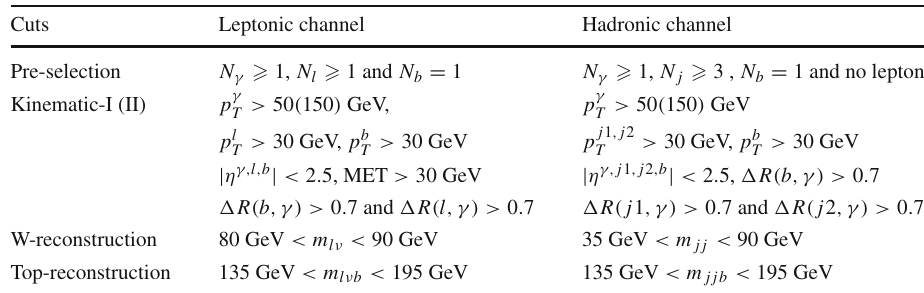
Table 3 The number of signal and relevant background events after each kinematic cuts in the analysis single lepton mode with L int = 100 fb − 1 Processes Signal ( λ q = 0 . 01) Signal( ζ q = 0 . 01)